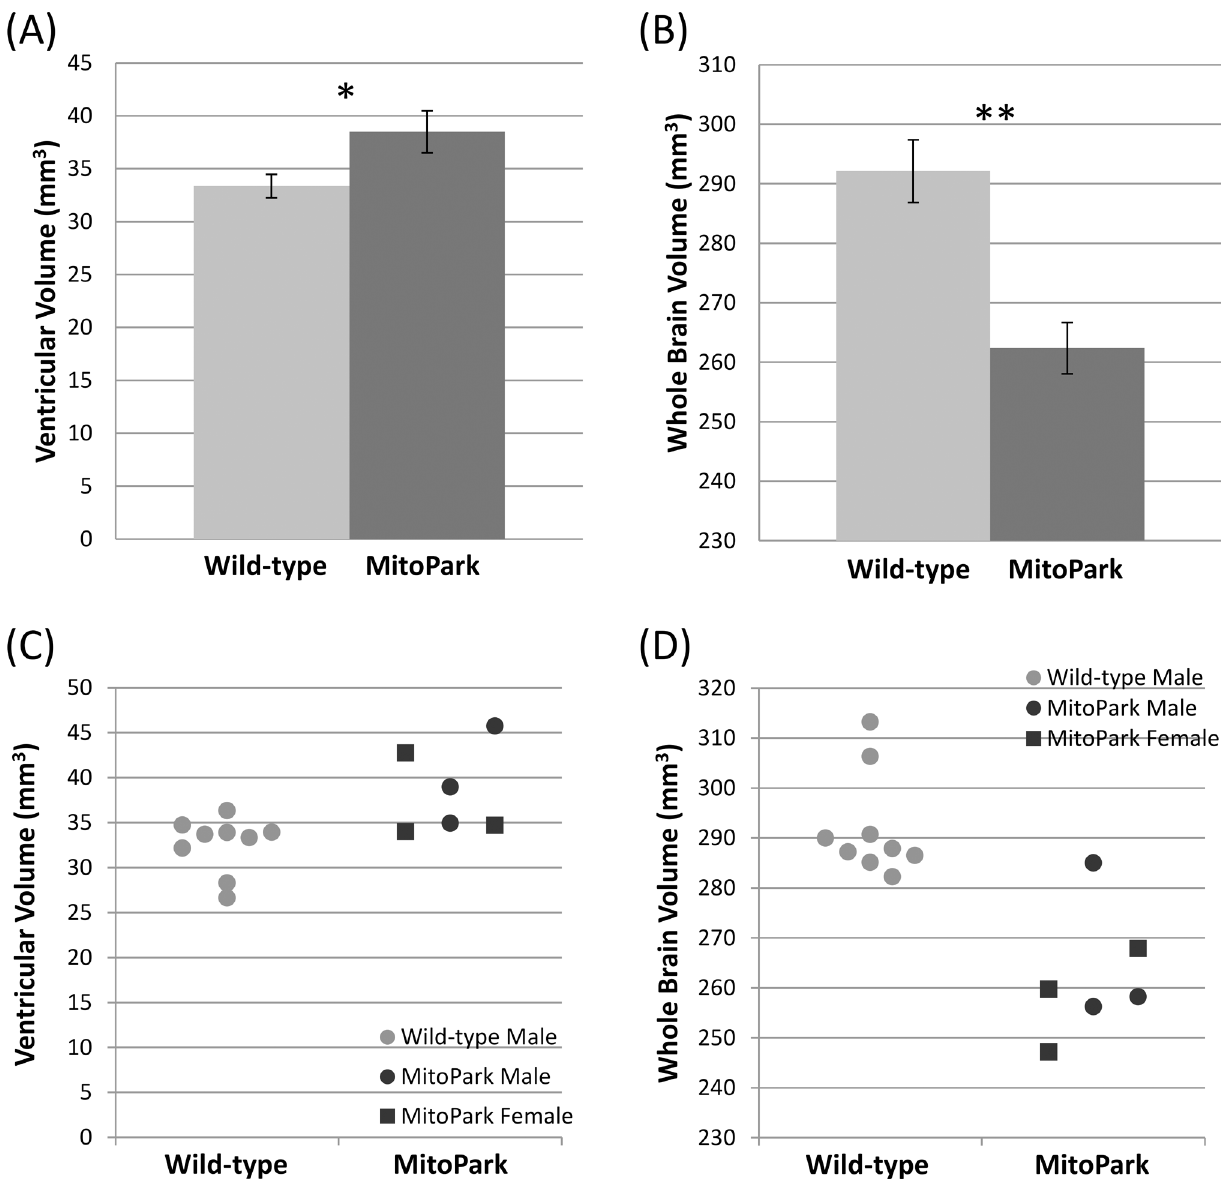
Fig 1. Group-averaged (A) ventricle and (B) whole-brain volumes of wild-type (n = 9) and MitoPark (n = 6) mice at 30 weeks of age. Mean ± SEM. * p < 0.05; ** p < 0.005 vs. wild-types. Scatter plots of individual (C) ventricle and (D) whole-brain volumes of male and female wild-type and MitoPark